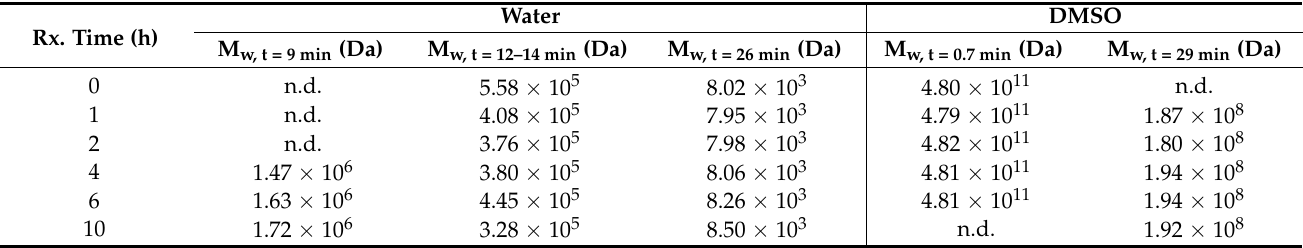
Table 1. Molecular weight (M w ) of cassava starch and starch laurates in water and DMSO solvents (n.d. = not detected).